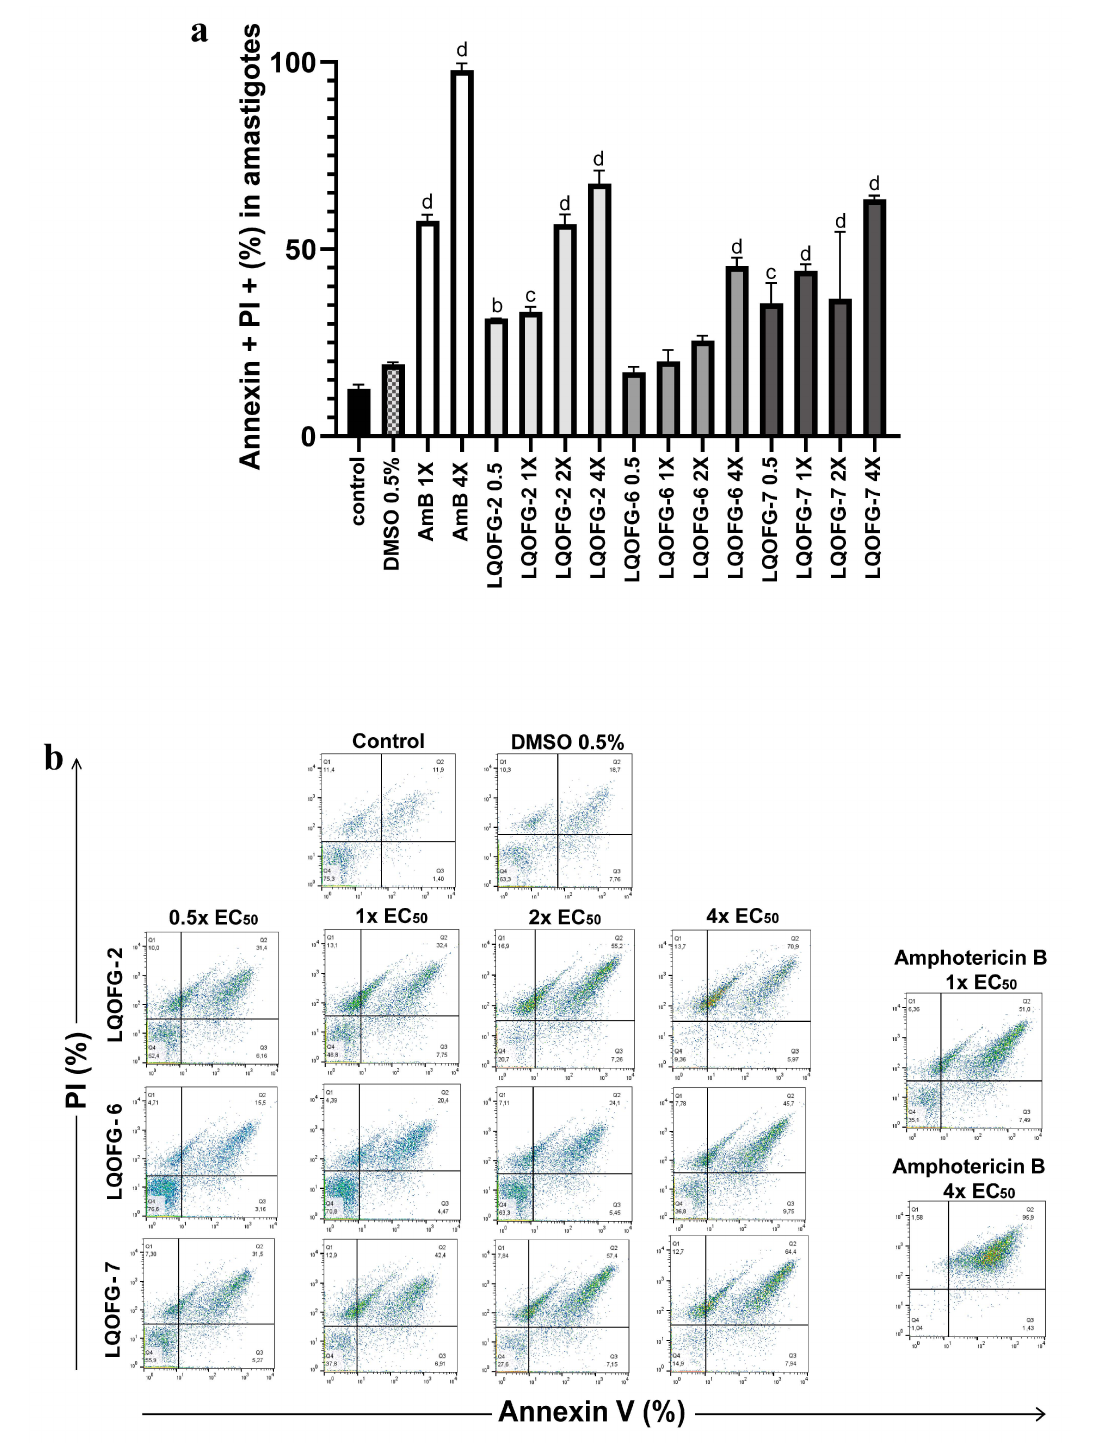
Figure 5. Cell death of axenic amastigotes following LQOFG-2, LQOFG-6, LQOFG-7, and AmB treatment. ( a ) Percentage of cell death by late apoptosis of axenic amastigotes. ( b ) Representative dot plots showing staining of L. infantum axenic amastigotes. Axenic amastigotes were incubated in the absence or presence of LQOFG-2, LQOFG-6, LQOFG-7, or AmB at concentrations of 0.5 × , 1 × , 2 × , or 4 × the EC 50 . Annexin V/PI (propidium iodide) staining was performed, and the samples were analyzed by flow cytometry. b p ≤ 0.01 vs. untreated control, c p ≤ 0.001 vs. untreated control, d p ≤ 0.0001 vs. untreated control, by analysis of variance (ANOVA) with the post hoc Tukey test compared to the untreated